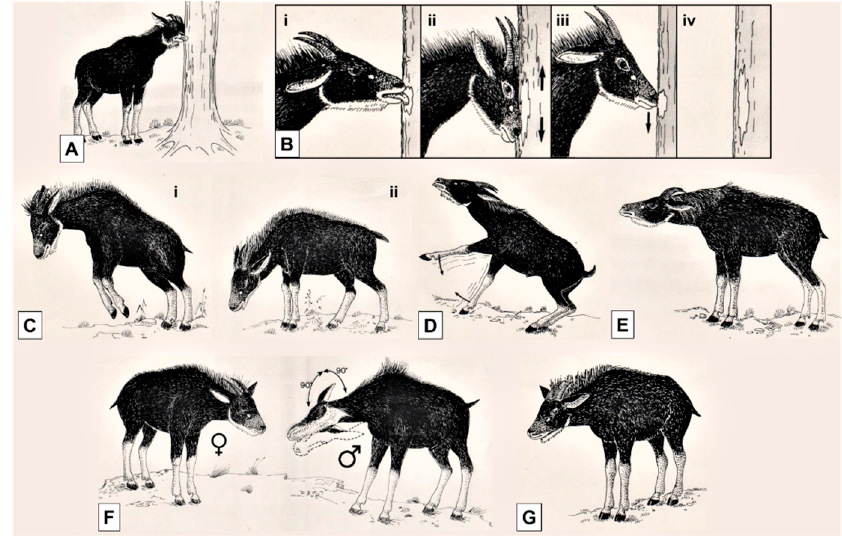
Figure 3. Behavioural repertoire of the mainland serow. Marking with ( A ) preorbital gland, with licking; ( B ) forehead (i, licking; ii, forehead rubbing; iii, scent sniffing; iv, eventual mark); ( C ) Head Down ( i ) first phase, with fore-feet stamping ( ii ) second phase, freezing in Head Down; ( D ) Foot Stamping; ( E ) Low Stretching; ( F ) Twisting (male), with female standing in Staring to the male; ( G ) Staring.